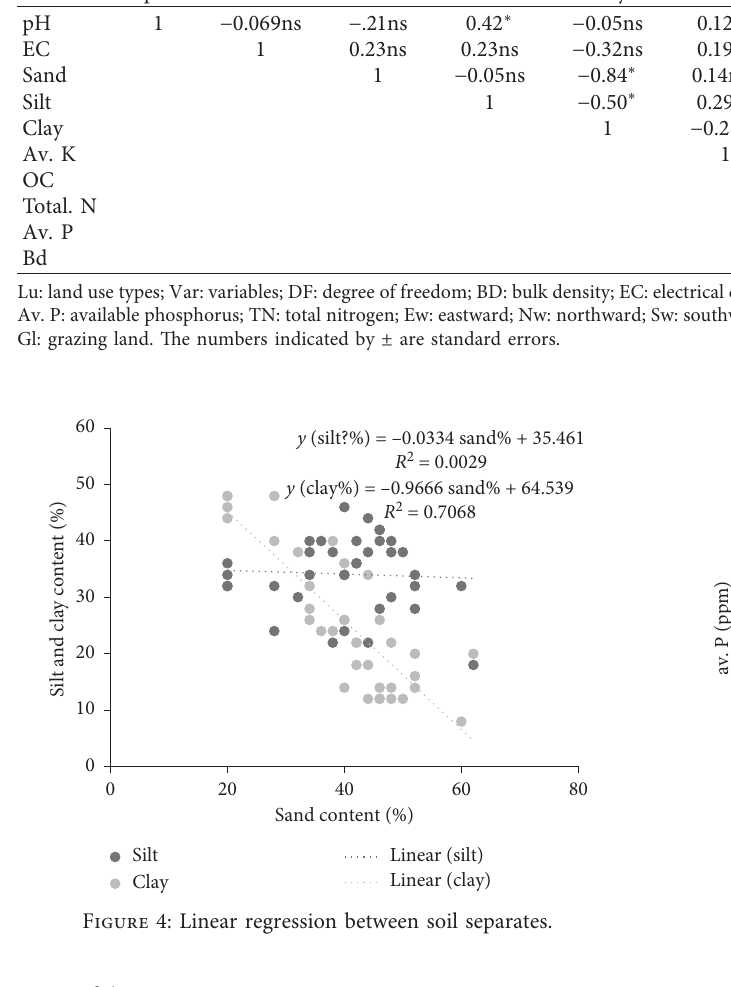
Figure 6: Linear regression of av. K versus av. P.